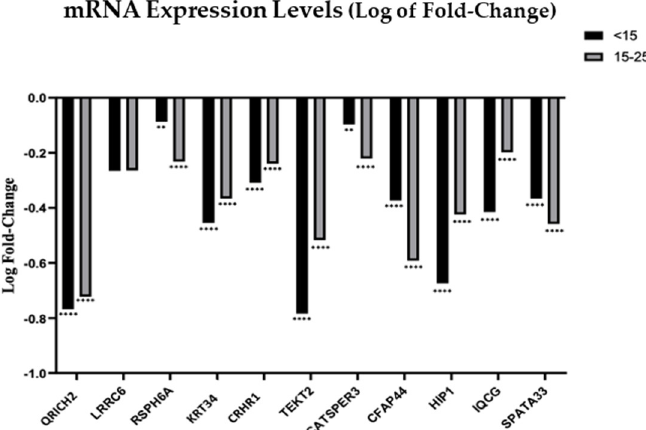
Figure 3. Log of fold change of the mRNA expression levels in spermatozoa from patients with RPM < 15% and RPM between 15–25%. Statistical significance was determined using the Kruskal–Wallis test, with α < 0.05. ** p < 0.01, and **** p < 0.0001. B2M was used as reference gene.